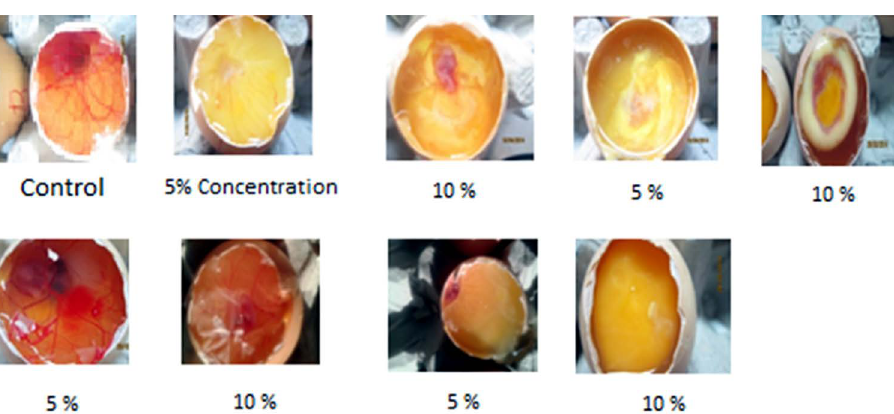
Fig. 2. Control and experimental eggs presenting formation and inhibition of blood vessels at different